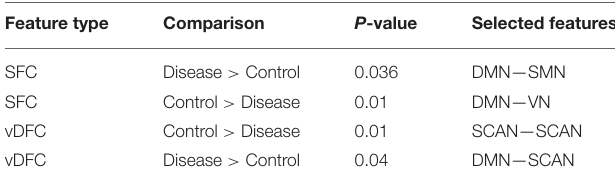
TABLE 16 | Network-to-network interactions selected by enrichment analysis for AD dataset. Feature